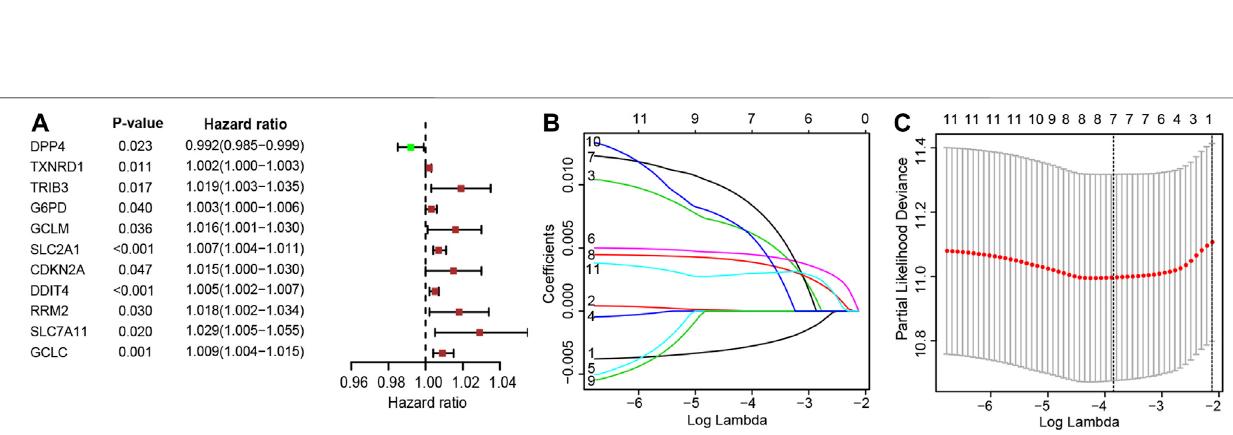
Frontiers in Genetics |